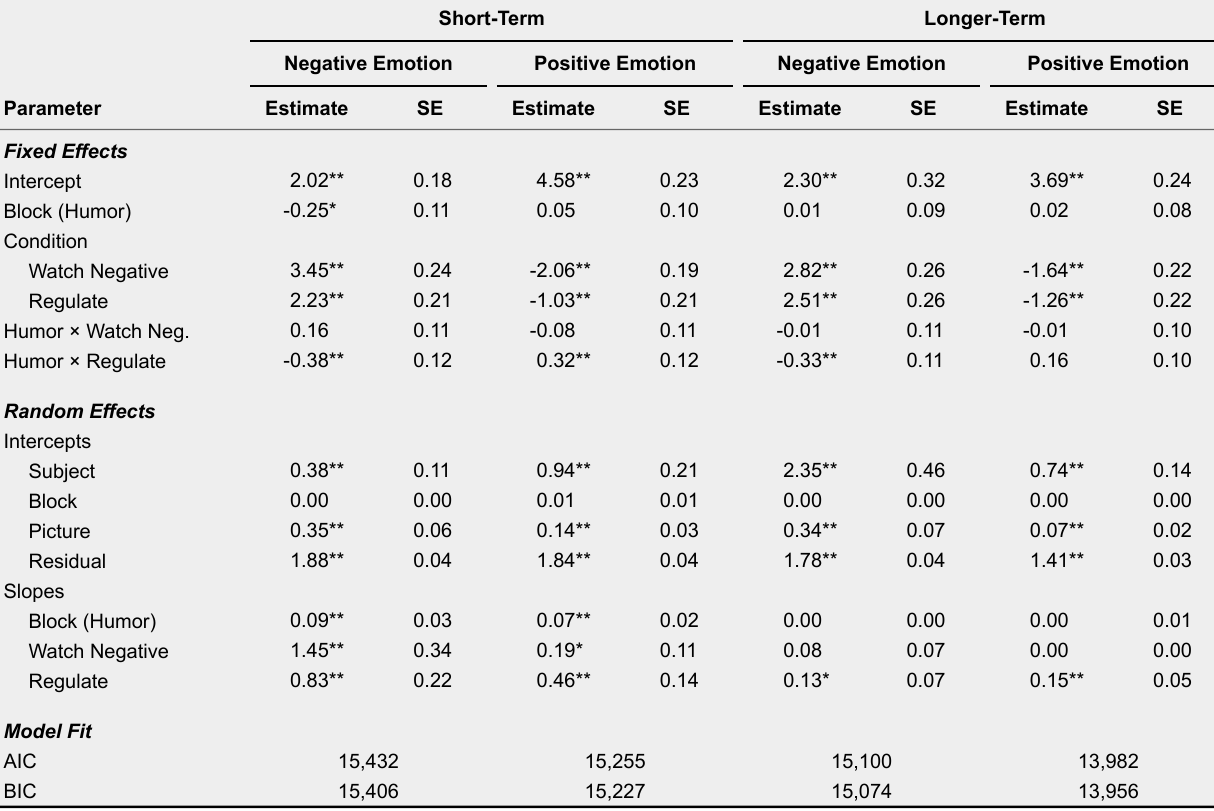
Multilevel Model Parameter Estimates for Short-Term and Longer-Term Emotion